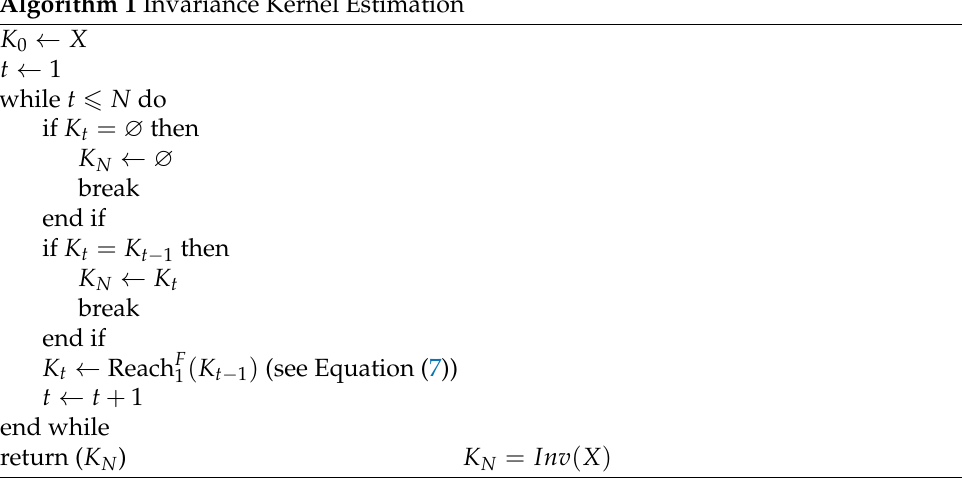
Algorithm 1 Invariance Kernel